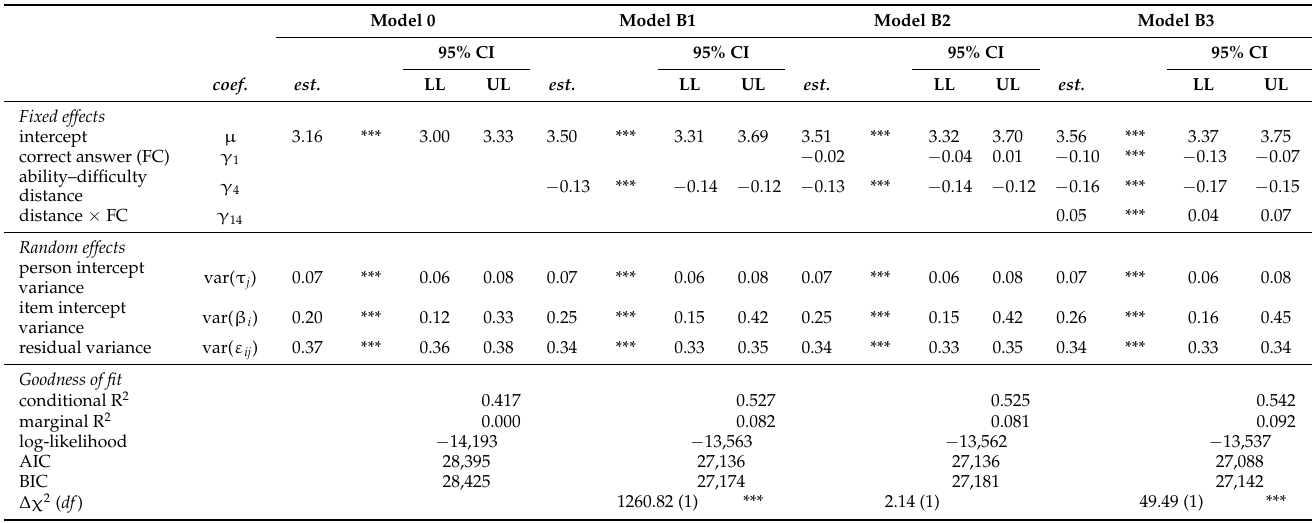
Table 3. Parameters of the models assessing distance–difficulty hypothesis interacting with the F > C